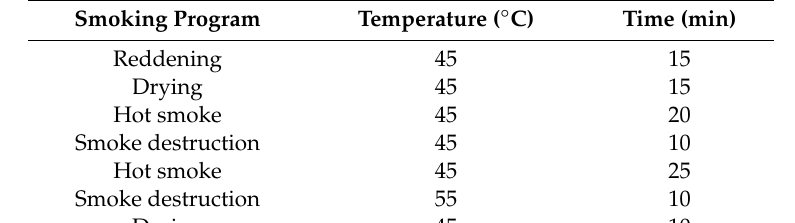
Table 2. The smoking program of the Reich Airmaster ® as used for preparing warthog Longissimus thoracis et lumborum (back) bacon.